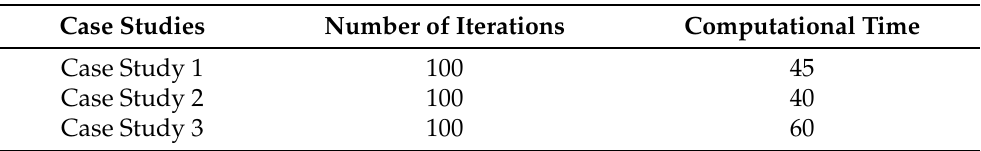
Table 1. Computational time and max number of iterations of the MOGA for the proposed case